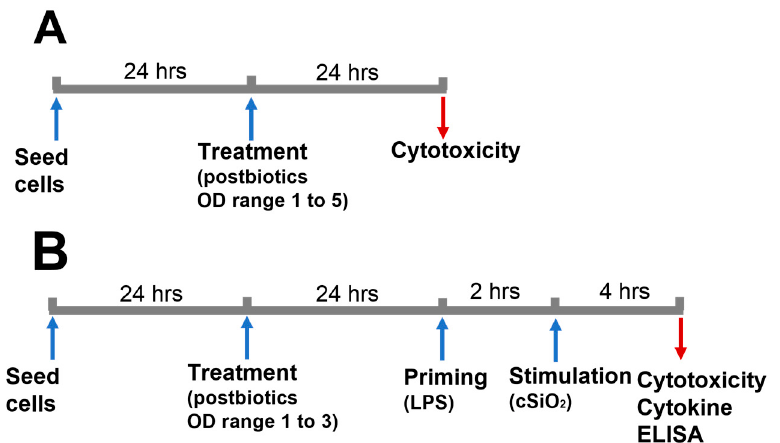
Figure 1. Experimental design. The experiment aims to: ( A ) determine the OD range to collect postbiotics that do not affect the cell viability for downstream experiments; and ( B ) investigate the impacts of postbiotics on cSiO 2 -induced cytotoxicity and the release of IL-1 cytokines of macrophages. The upward-facing arrows indicate the addition of cells and reagents, while the downward-facing arrows indicate the removal of samples for analyses.